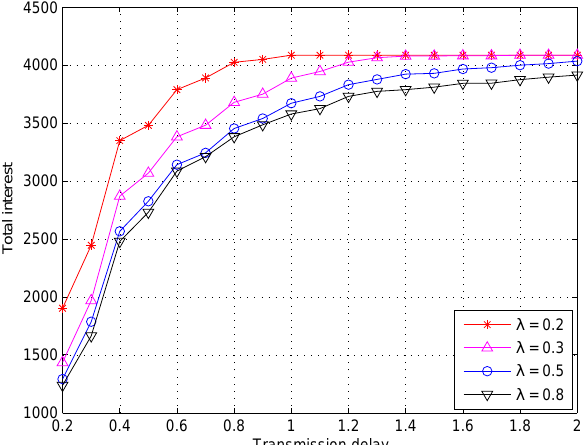
Figure 7. The total user interest as a function of the transmission delay with varying user arrival rate λ ( P T = 2 W and ξ = 0.9).